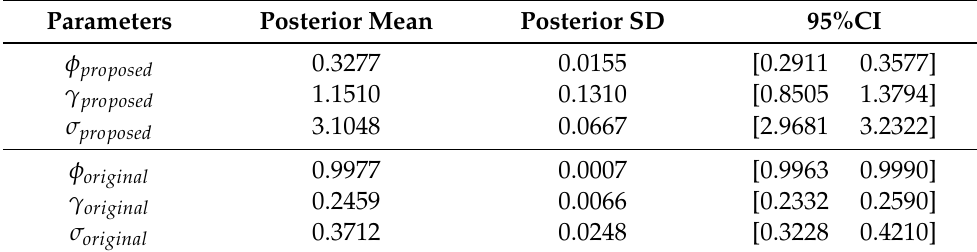
Table 40. Comparison of estimated parameters (27 July 2016, JAL, Tokyo,